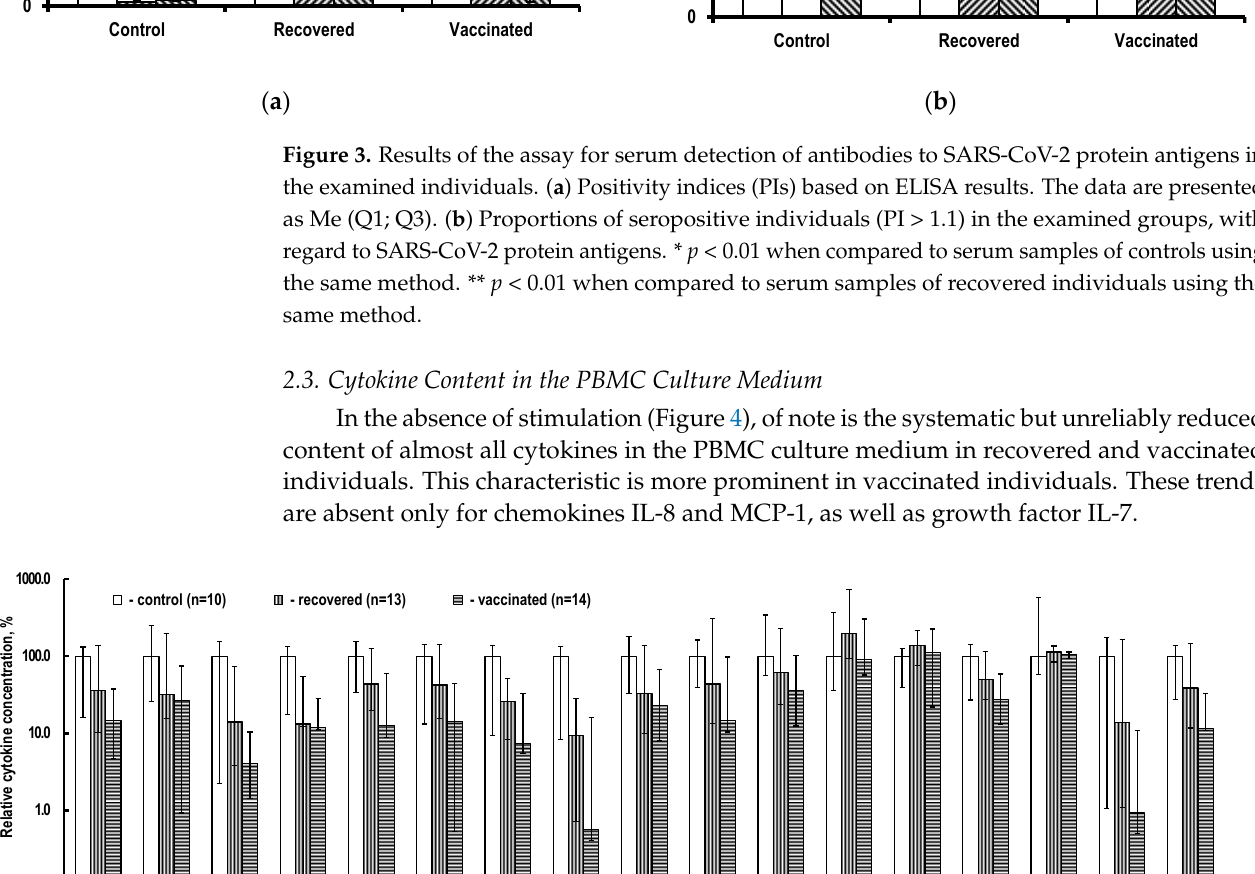
IL-17 IFN-g Figure 4. Cytokine content in the PBMC culture medium without stimulation. The relative cytokine concentration is the ratio of the measured absolute concentration of a cytokine in a sample to the median absolute concentration of this cytokine in control individuals’ samples. The data are presented as Me (Q1; Q3).